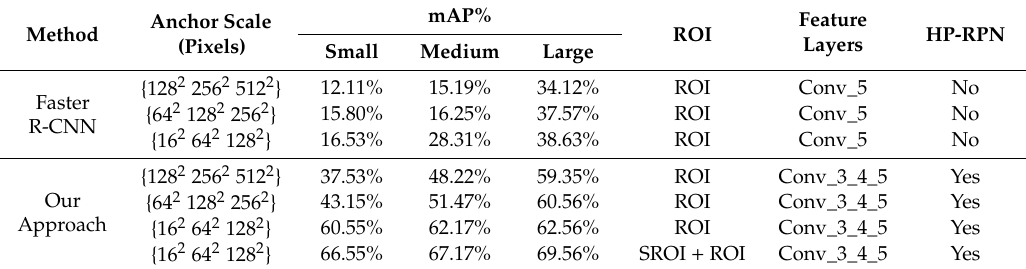
Figure 15. The distribution of aspect ratios of traffic signs. Each blue triangle represents a traffic sign and the orange straight line represents the average aspect ratio of all the traffic signs in the GTSDB and CTSD dataset. Table 2. The comparison of detection results with di ff erent